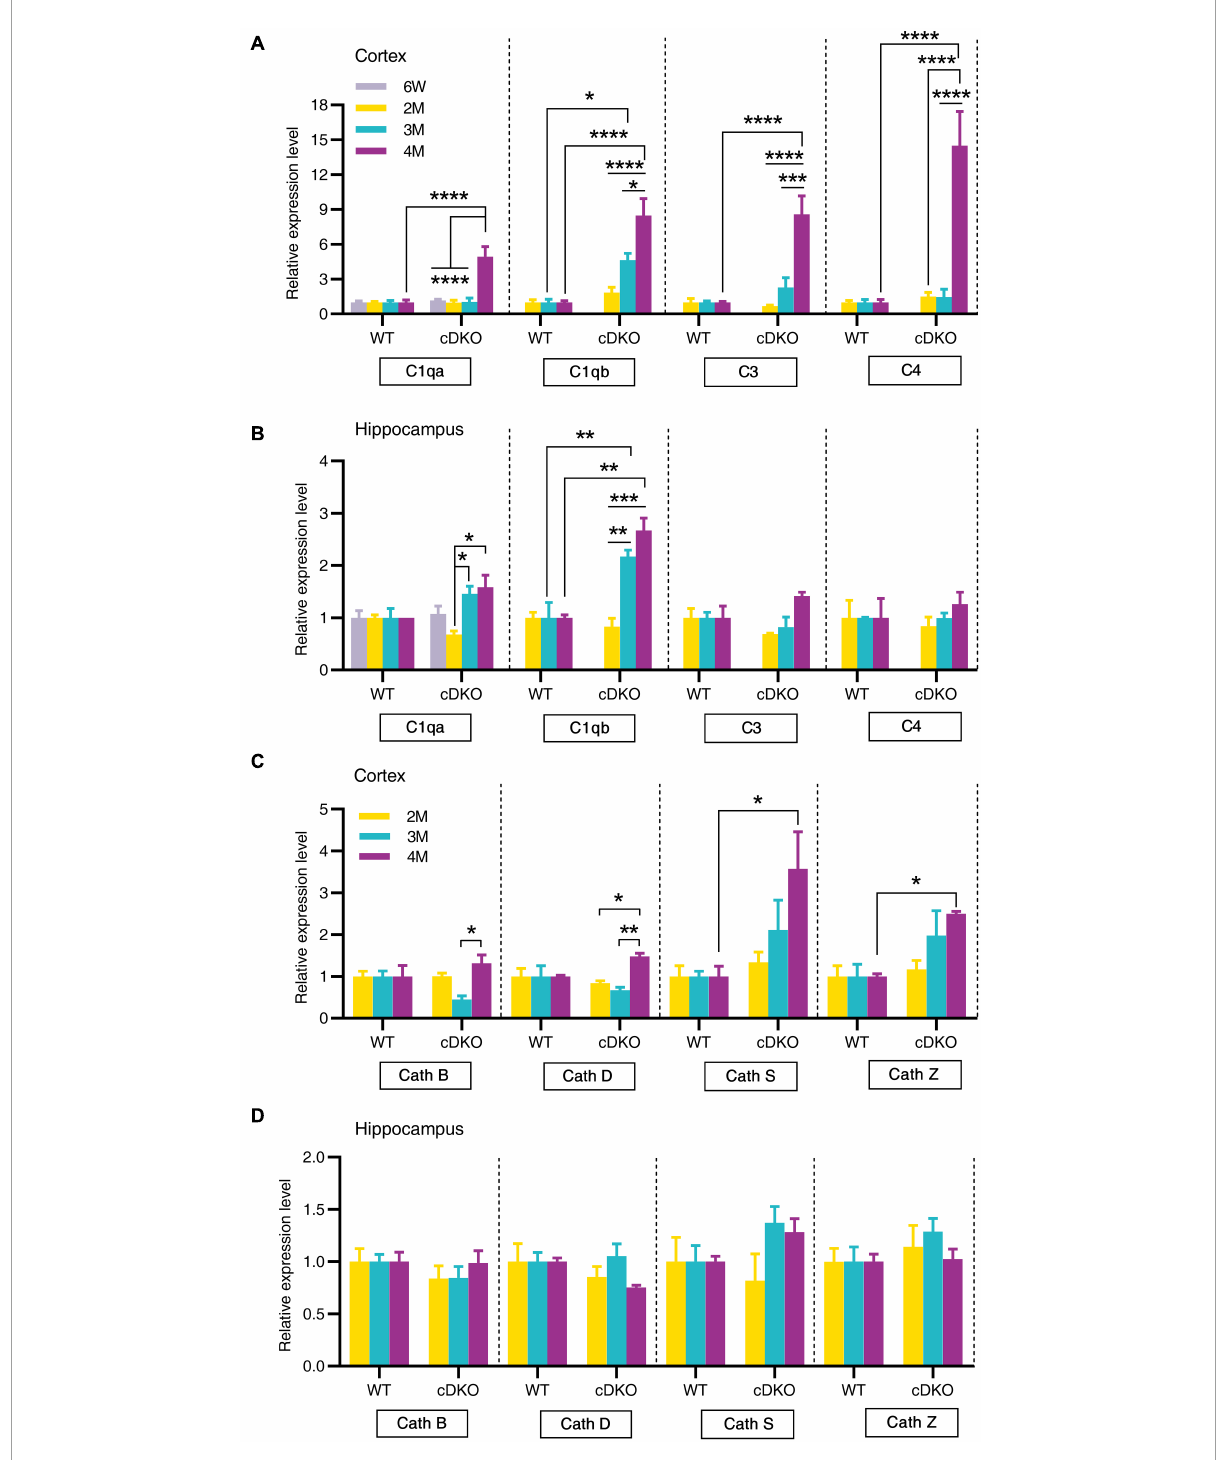
FIGURE6 Age-related increase in mRNA levels of complement genes and cathepsin genes in the cortex and hippocampus of cDKO mice. (A,B) Relative expression of complement C1qa, C1qb, C3, and C4 normalized to GAPDH in the cortex (A) and hippocampus (B) of WT and cDKO mice at the ages of 6 weeks, 2, 3, and 4 months analyzed by RT-PCR. (C,D) Relative expression of cathepsin (Cath) B, D, S and Z normalized to GAPDH in the cortex (C) and hippocampus (D) of WT and cDKO mice at the ages of 6 weeks, 2, 3, and 4 months analyzed by RT-PCR. Data are presented as the mean ± SEM ( n = 4–5 for each group). One-way ANOVA analysis followed by Turkey’s test, * p < 0.05, ** p < 0.01, *** p < 0.001, **** p <